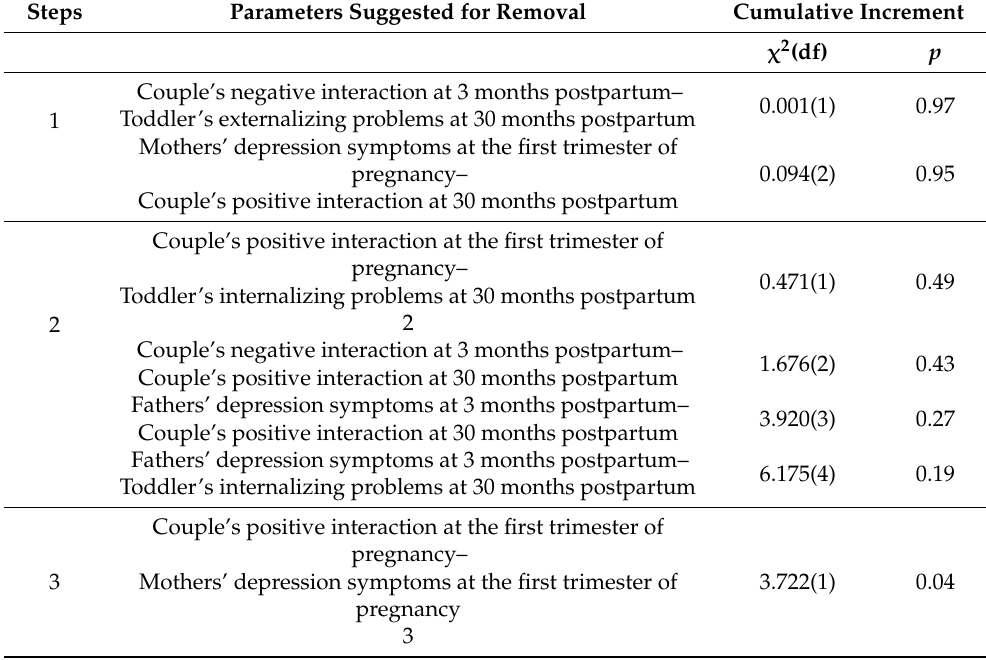
Table 1. Multivariate Wald test results of the initial